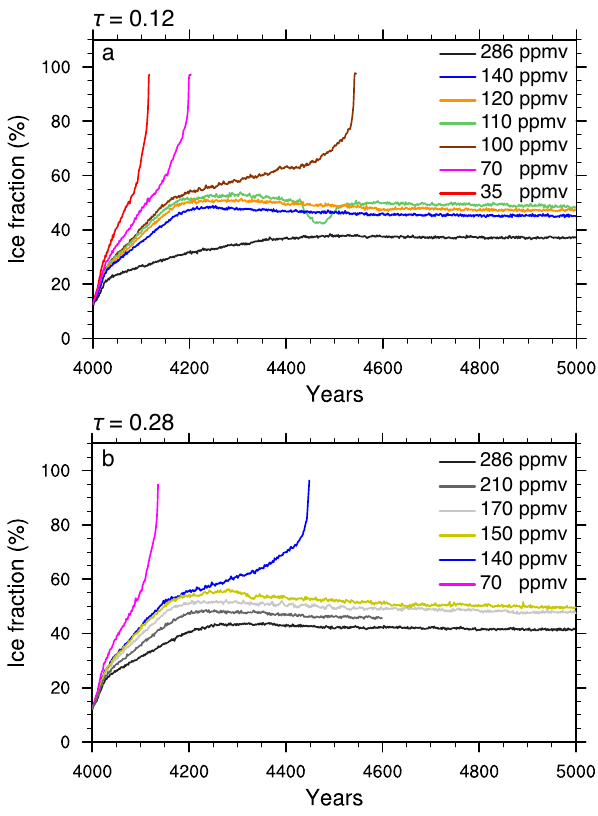
Fig. 5. Same as Fig. 4 except that this is for the 570Ma continental configuration. TSI is fixed to 0.94TSI 0 for all simulations. Note that the dip in the run with p CO 2 = 110 ppmv in (a) is probably due to numerical instability.